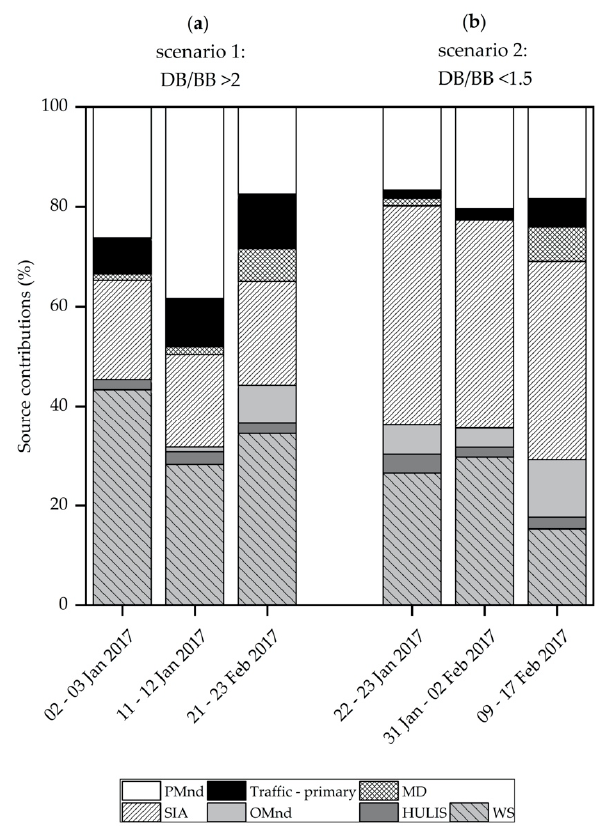
Figure 10. Relative source contributions of six time periods grouped by their major differences in DB/BB PM 10 ratios for sampling station Graz DB (PM 2.5 ). Abbreviations: PMnd = PM not defined, MD = mineral dust, SIA = secondary inorganic aerosols, OMnd = organic material not defined, WS = wood smoke aerosol.